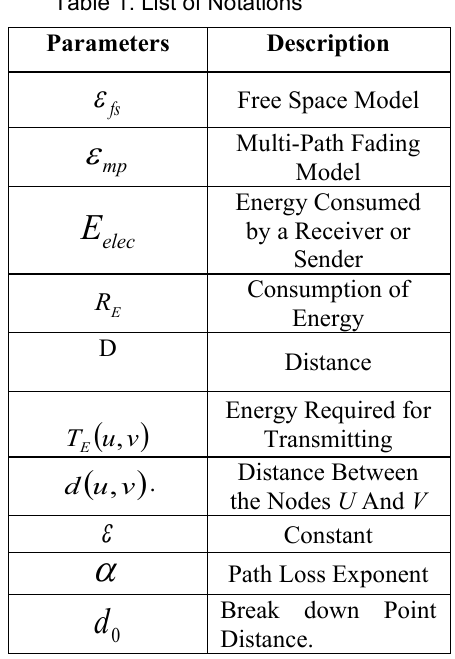
Table 1. List of Notations